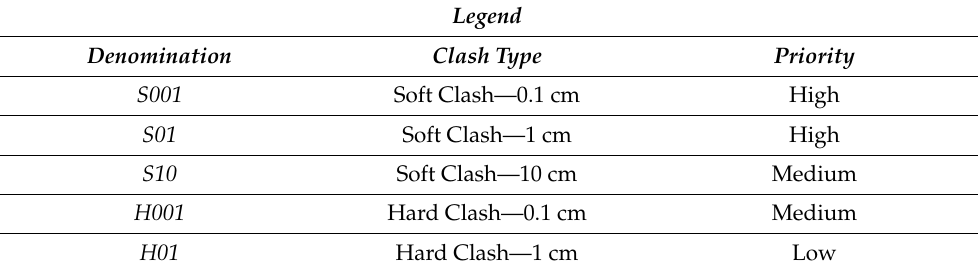
Table 2. Legend of the degrees of priority of the clash.